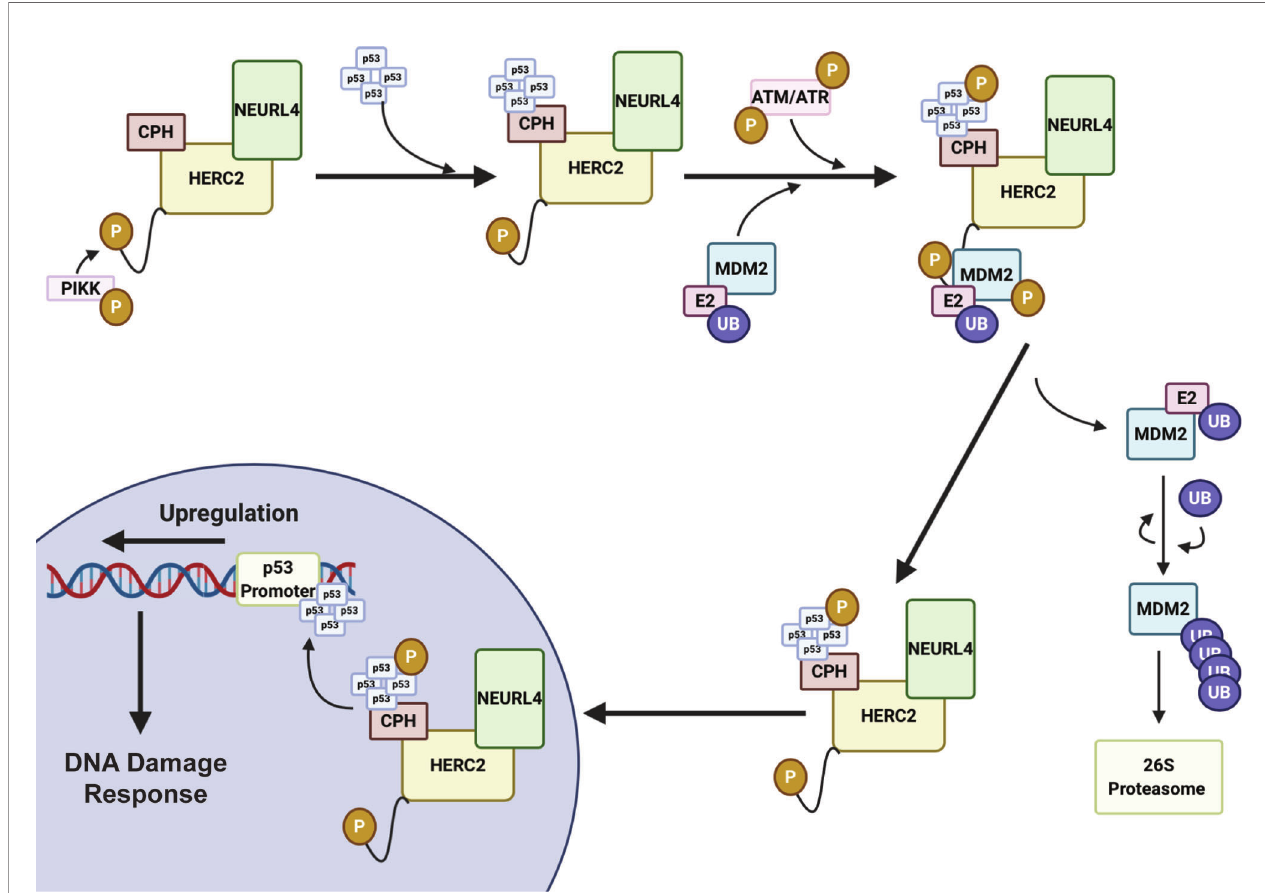
FIGURE 3 | HERC2 serves as a master regulator of p53 gene transcription in response to DNA damage. HERC2 recruits oligomerized p53 with its CPH domain to form a NEURL4-HERC2-p53 ternary complex and is phosphorylated at T4827 on its C-terminal tail by phosphatidylinositol 3-kinase-like protein kinase (PIKK). The HERC2-NEURL4-p53 ternary complex coordinates with the RING E3 ubiquitin ligase MDM2. The kinases Ataxia telangiectasia mutated (ATM) and Ataxia telangiectasia and Rad3 related (ATR) are also recruited to the multiprotein structure. ATR and ATM carry out the phosphorylation of MDM2 and oligomerized p53. Phosphorylated MDM2 becomes unstable and dissociates from the HERC2 scaffolding to allow for its K48 auto-polyubiquitylation and the cytoplasmic stability of the HERC2-NEURL4-p53 ternary complex. The HERC2-NEURL4-p53 ternary complex migrates to the nucleus where it releases oligomerized p53. p53 binds to the p53 promoter regions where it initiates the upregulation of genes to aid in cellular DNA repair and the DNA damage response. This fi gure was created with